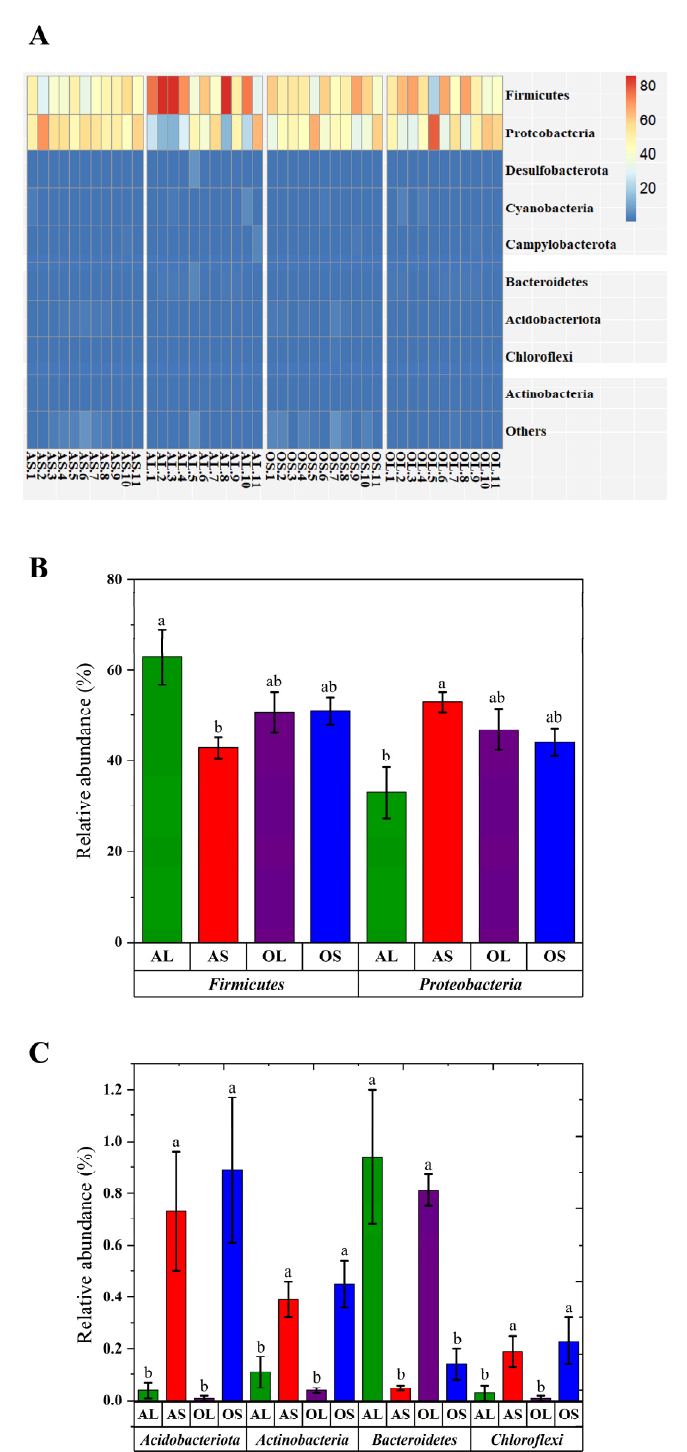
Figure 3. Effects of bamboo part consumption and age on the taxa distribution at the phylum level in giant pandas. ( A ) Heat map of relative abundance of phyla. ( B , C ) Significantly different phyla in feces among four groups. AS ( n = 11), adult giant pandas fed with bamboo shoots; AL ( n = 11), adult giant pandas fed with bamboo leaves; OS ( n = 11), old giant pandas fed with bamboo shoots; OL ( n = 11), old giant pandas fed with bamboo leaves. In panel ( B , C ), values are presented as mean ± standard error; bars with different letters mean significant difference ( p <